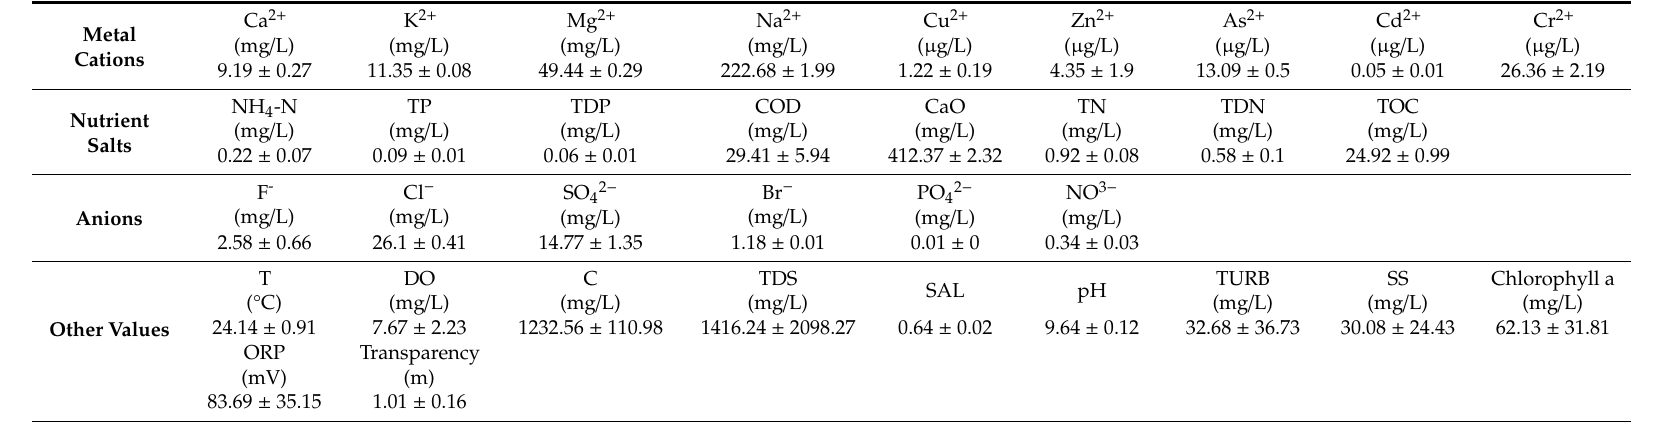
Table 2. The water quality of Chenghai Lake in